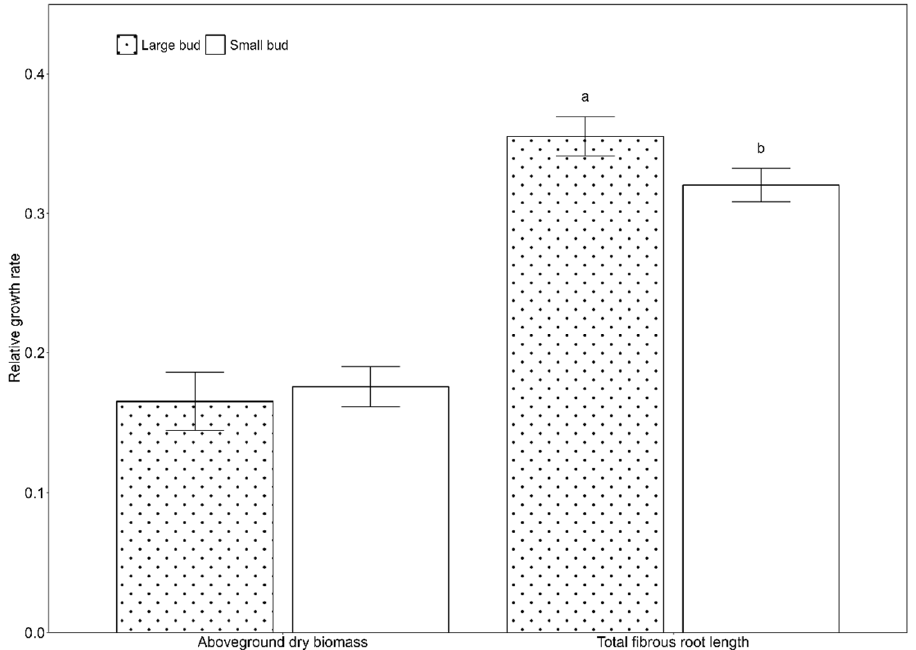
Figure 3. The relative growth rates of aboveground dry biomass, leaf area and total fibrous root length from 32 to 46 DAP in EXP.2. Note: The different lower-case letters indicate significant probability difference at p < 0.05 among sampling dates. The error bars represent standard errors ( n = 3).